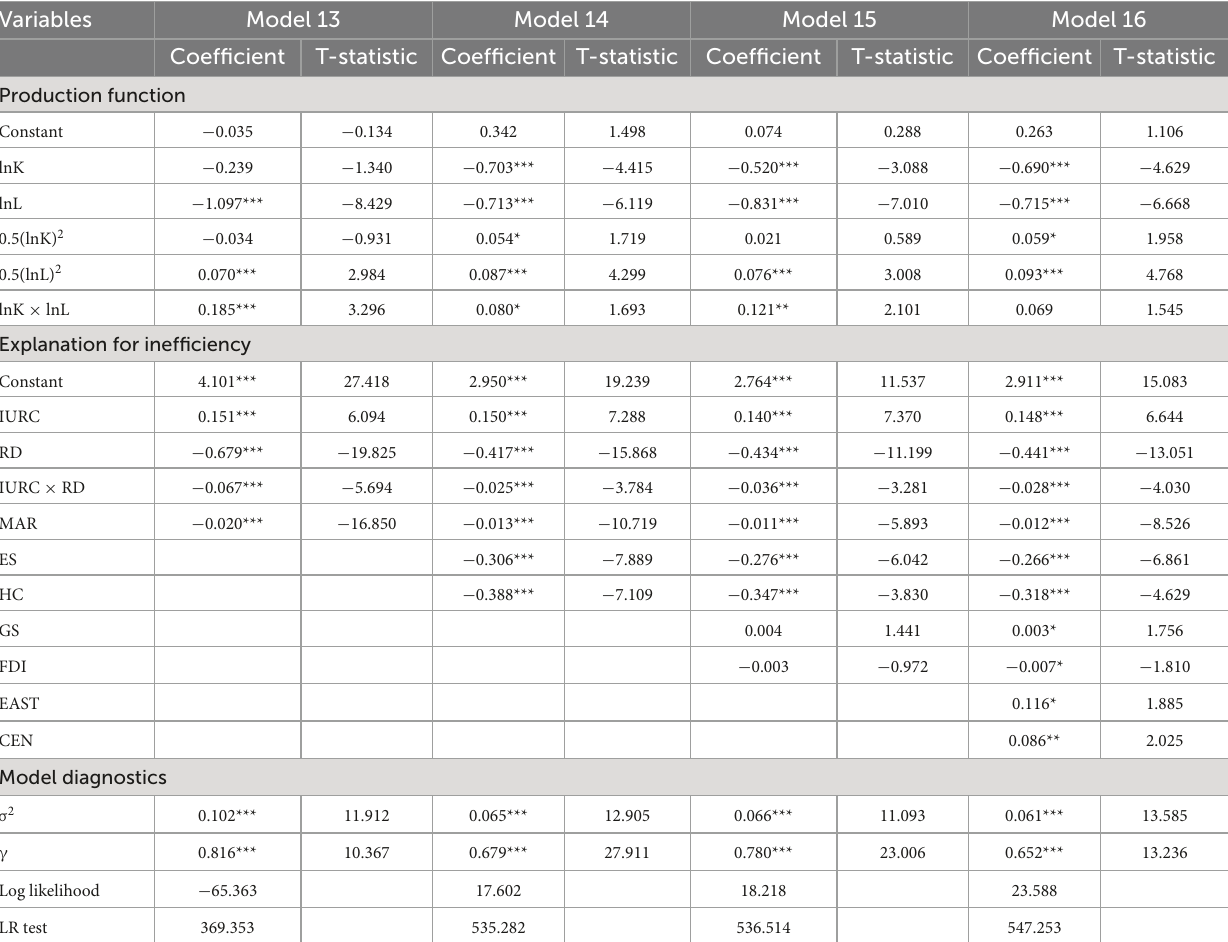
TABLE 10 Results of the robustness test of the dual effects of